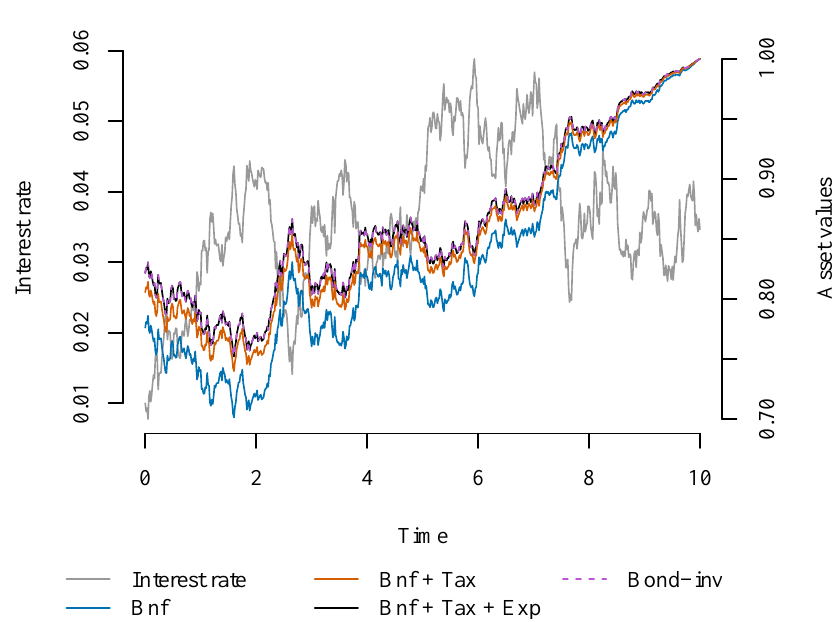
Figure 1. A simulated path for the Vasicek interest rate model (left axis) and relevant associated value processes (right axis). The total value of the hedging portfolio is illustrated as the black line “Bnf + Tax + Exp”. The value of the benefits alone is illustrated as the blue line “Bnf”, and the value of the benefit and tax payments is illustrated as the red line “Bnf + Tax”. The value of the investment in the bond (the dashed purple line “Bond-inv”) is, here in the Vasicek case, identical to the value of the whole hedging portfolio and therefore coincides with the black line “Bnf + Tax + Exp”.